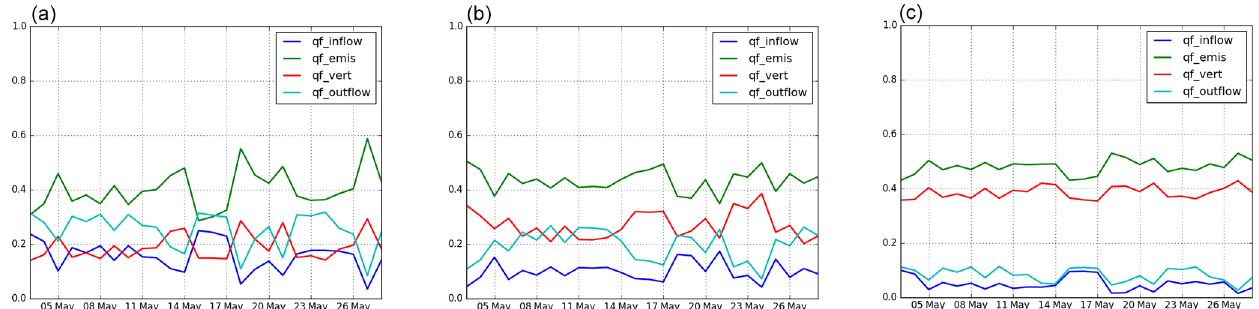
Figure 17. Daily-weighted mass flux of NO at BONAP (a) , CELES (b) and BP_EST (c) traffic stations.